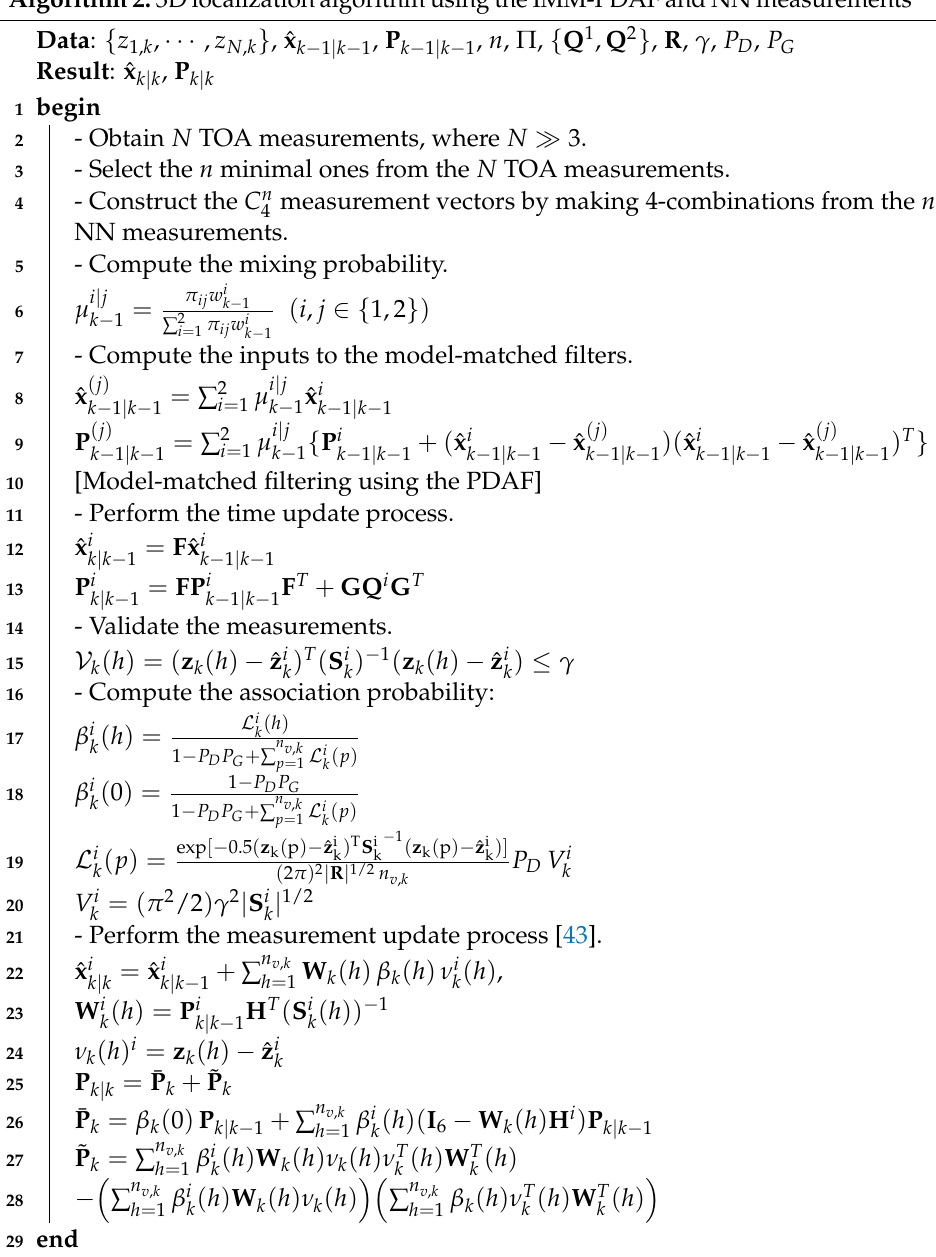
Algorithm 2: 3D localization algorithm using the IMM-PDAF and NN